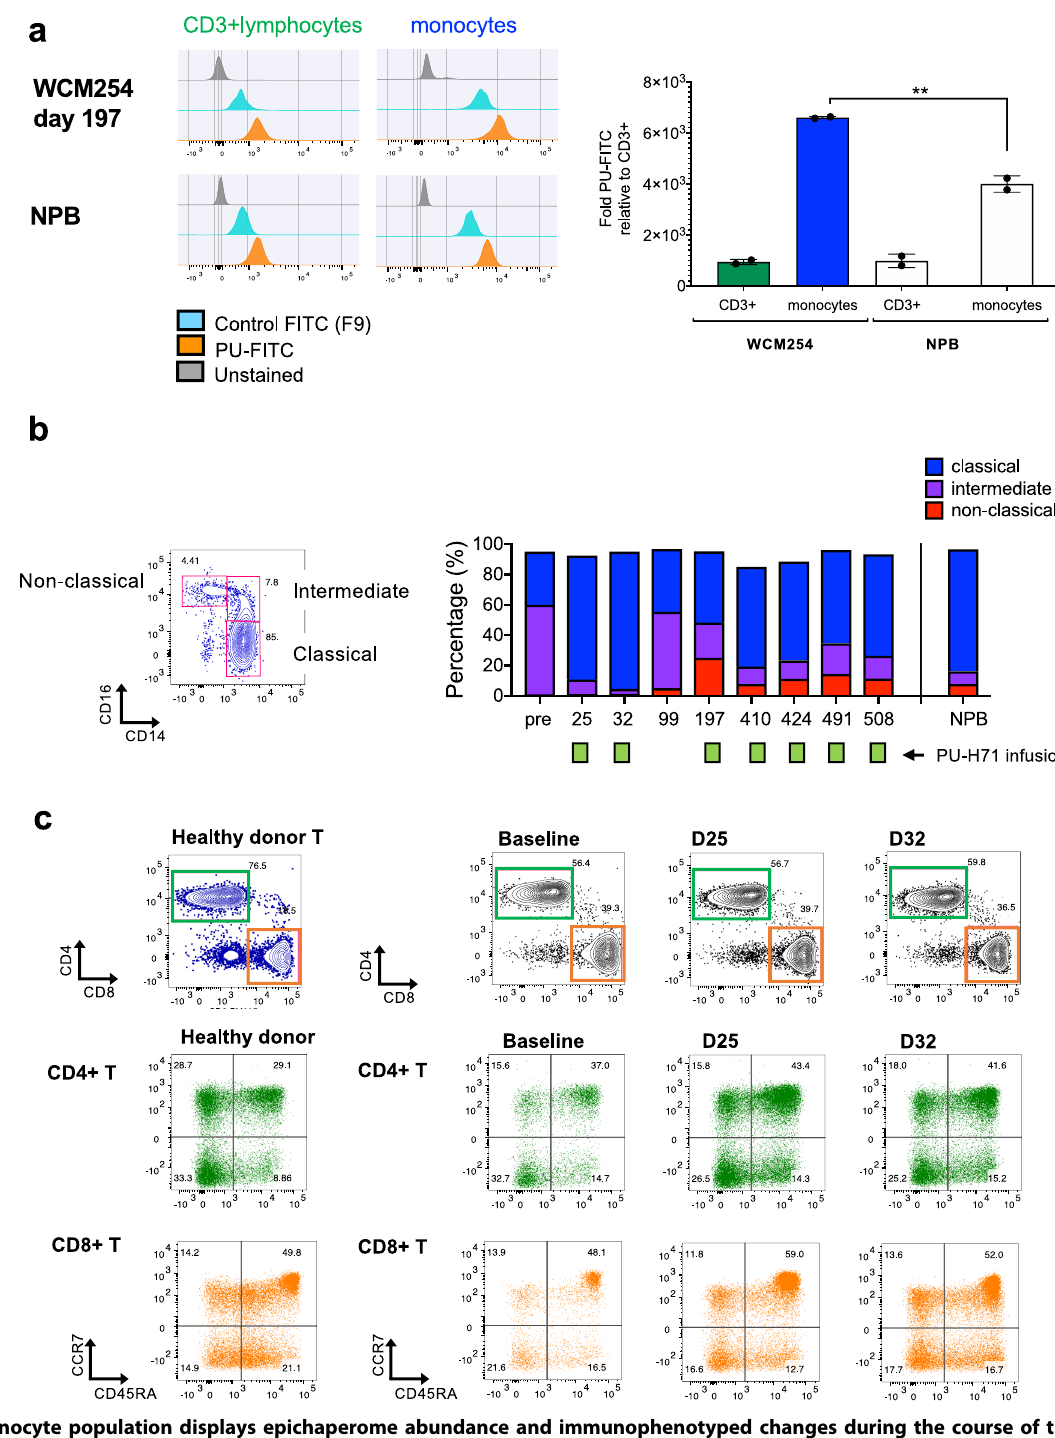
Fig. 4 Monocyte population displays epichaperome abundance and immunophenotyped changes during the course of treatment with PU-H71 while T lymphocytes are not affected. a Epichaperome abundance in monocytes and CD3 + T-cell lymphocytes in WCM254 compared with normal PB lymphocytes (NPB). Graph, mean ± SD of MFI of monocytes/MFI of CD3 + lymphocytes. b Representative monocyte subsets (classical, intermediate, and non-classical) based on CD14 and CD16 expression in normal healthy donor (left). Chronological changes in monocyte subsets in patient WCM254 during PU-H71 therapy (right). Pro-in fl ammatory subsets CD14 high CD16 + (intermediate) and CD14 low CD16 + (non-classical) decreased after PU-H71 treatment re fl ecting proportions similar to normal monocyte subsets. c Phenotyping of T-lymphocytes in WCM254 at baseline, day 25 and day 32, with representative T cells from a healthy donor shown on the left. Proportion of CD4 + and CD8 + T lymphocytes and naive/central memory/effector/terminally differentiated effector T cells of each CD4 + and CD8 + T cells did not show changes in WCM254 under PU-H71 treatment (right three